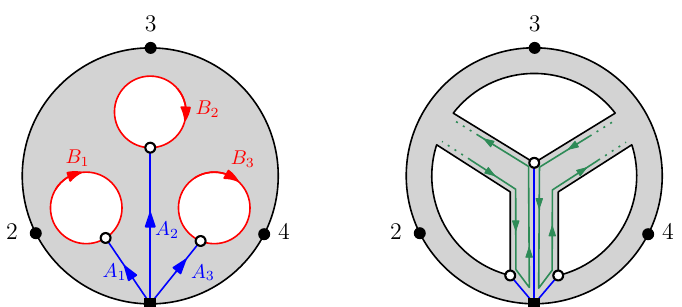
Figure 13 . Mercedes graph degeneration. Left: the decomposition of the Riemann surface in terms of A - and B -cycles. The loop momenta ‘ I are flowing through A I for I = 1 , 2 , 3 . Right: the J cycles (green) get trapped between the B cycles in the neighborhood of the Mercedes